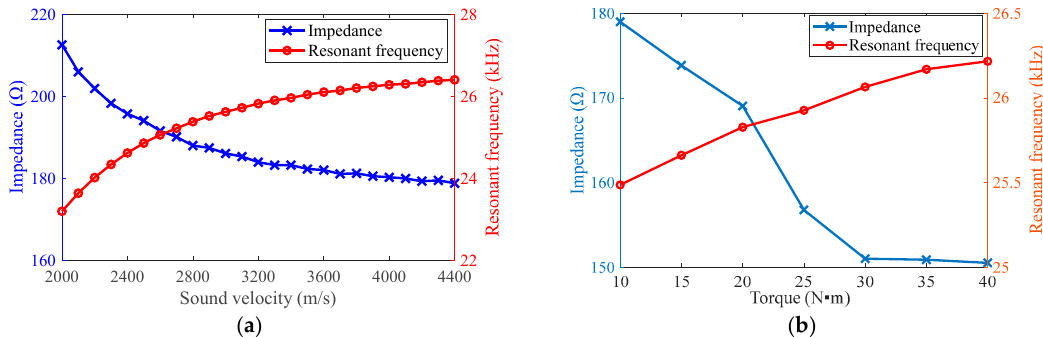
Figure 6. Resonant frequency and impedance with different sound velocity and tightening torque. ( a ) Theoretical calculation; ( b ) Experimental measurement.